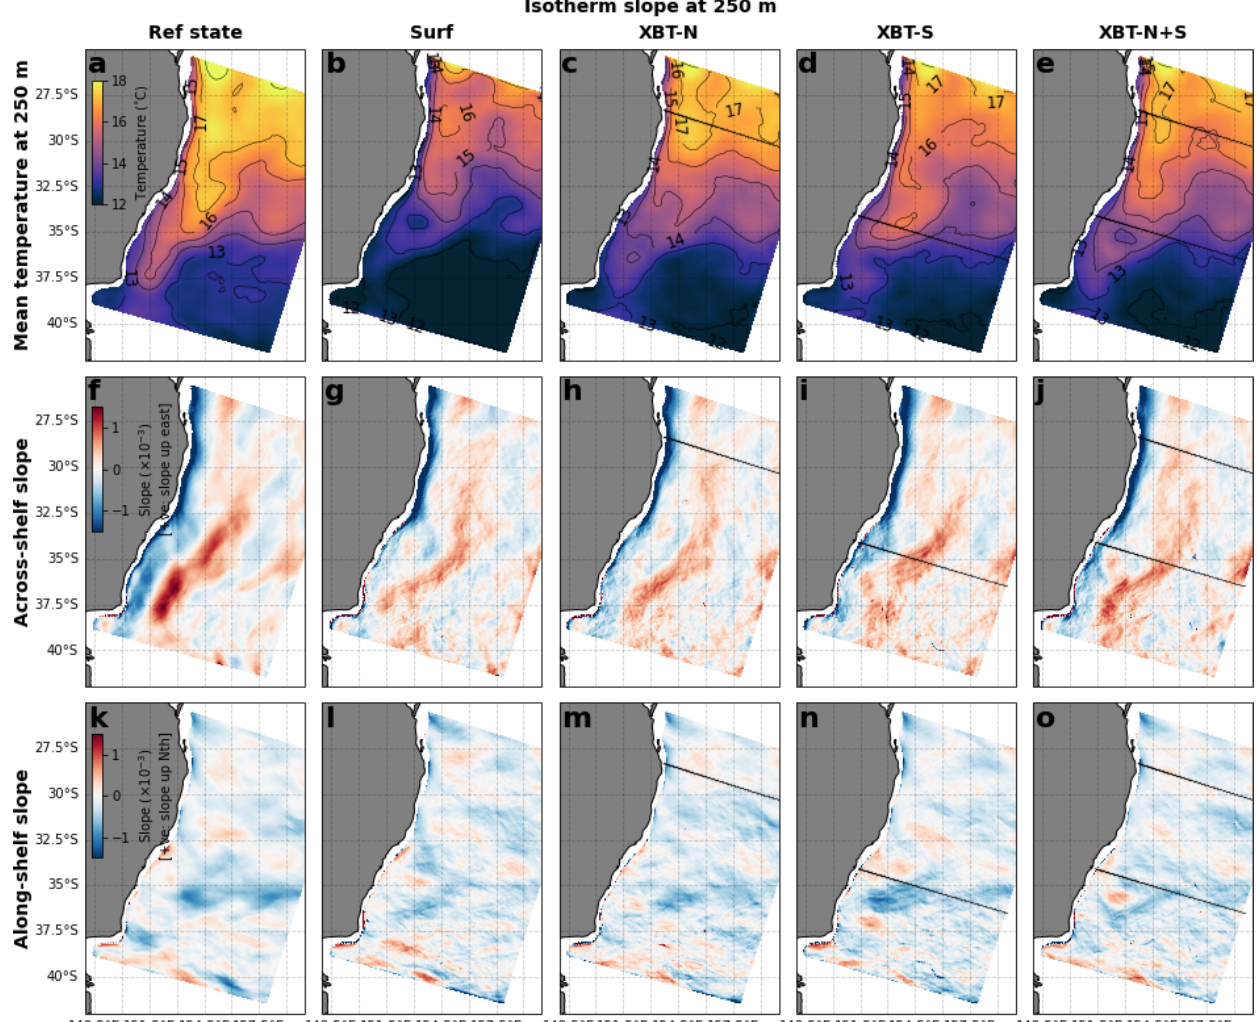
Figure 4. The mean temperature at 250m is shown for (a) the Ref state and the (b) Surf, (c) XBT-N (d) XBT-S, and (e) XBT-N+S OSSEs. The across-shelf isotherm slope at 250m is shown for the (f) Ref state and the (g) Surf, (h) XBT-N, (i) XBT-S, and (j) XBT-N+S OSSEs. Likewise, the along-shelf isotherm slope at 250m is shown for the (k) Ref state and the (l) Surf, (m) XBT-N, (n) XBT-S, and (o) XBT-N+S OSSEs. A positive across-shelf slope is upwards sloping towards the east, and a positive along-shelf slope is upwards sloping towards the north. The XBT-N and XBT-S transect locations are marked in the respective panels. Axes with latitudes are labelled ◦ S, and axes with longitudes are labelled ◦